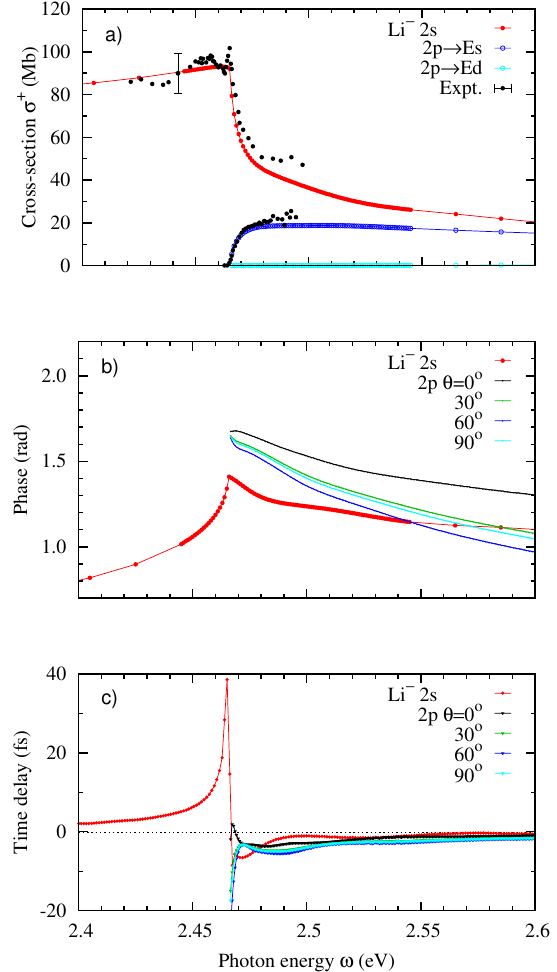
Figure 5. (Color online) ( a ) The cross section (8), ( b ) the phase of the transition amplitude, and ( c ) the time delay (9) of H − in various photodetachment channels near the n = 2 threshold. Experimental cross section results [52,53] are displayed in the top